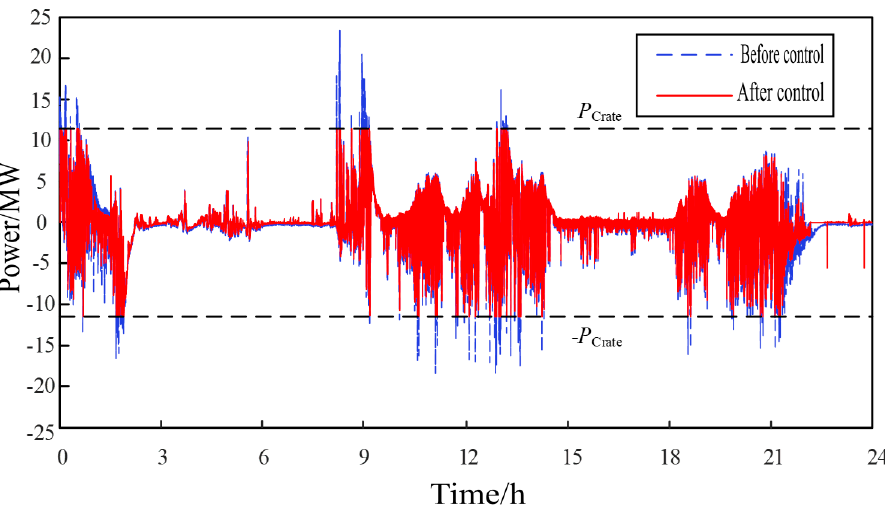
Figure 11. Comparison of charge and discharge power curves of supercapacitors before and after control.